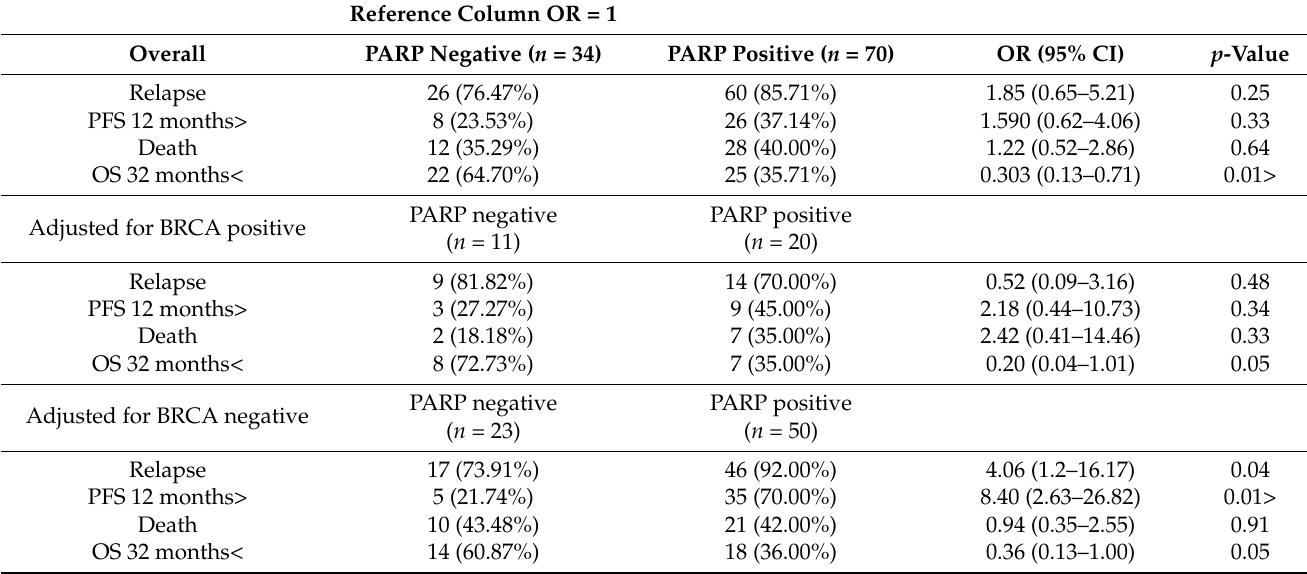
Table 3. Subgroup analysis of odds ratios adjusted to BRCA